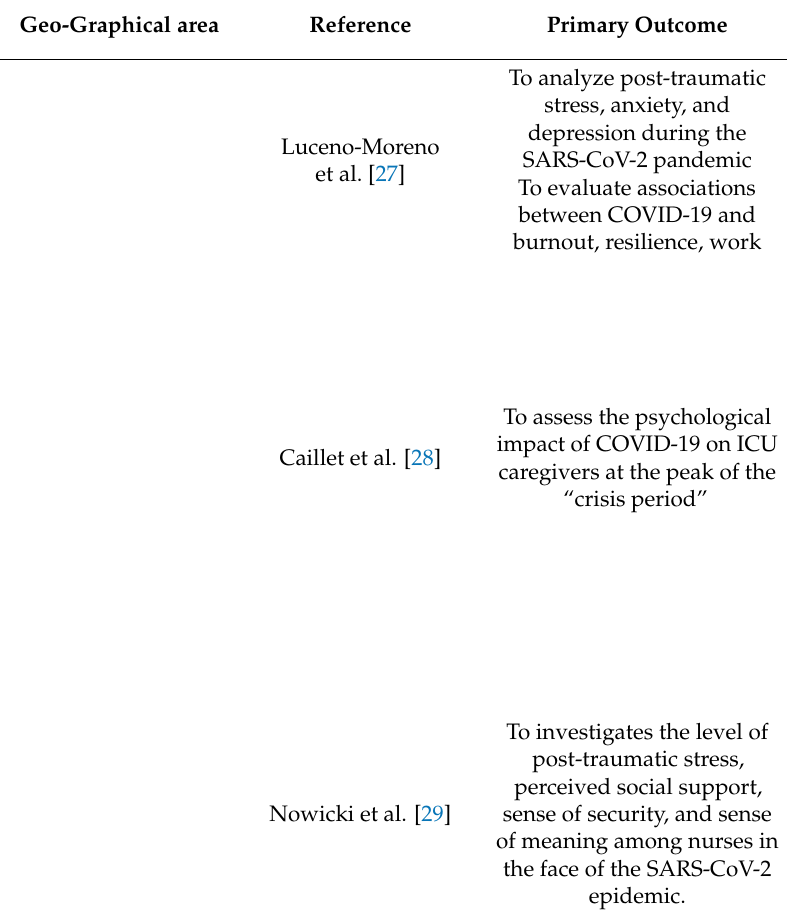
Methods/Investigation